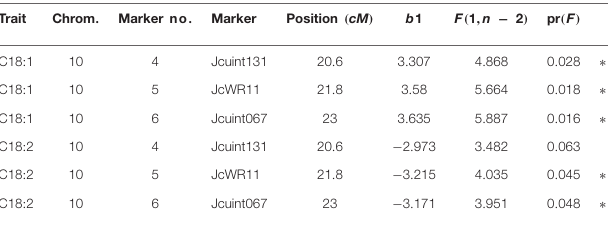
TABLE 1 | Single point analysis for the effect of WR11 on lipid profile in Jatropha backcrossed population. Trait